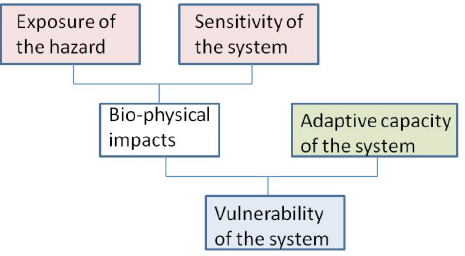
Figure 2. Components of vulnerability (adopted from IPCC,